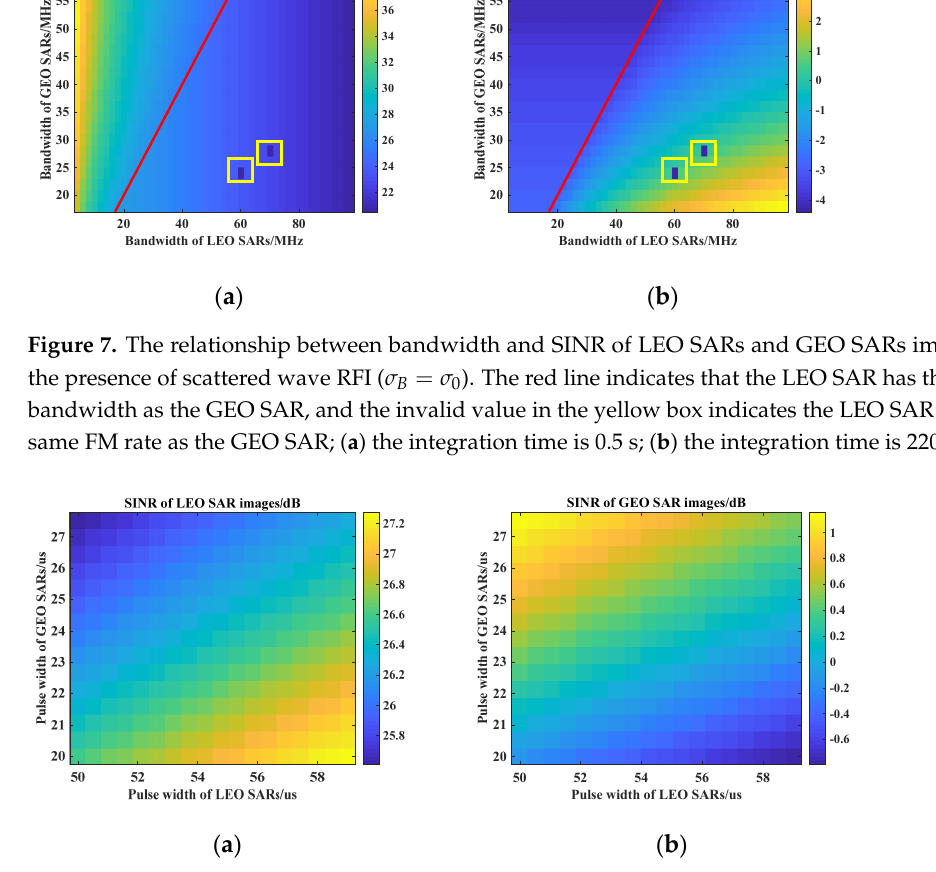
Figure 8. The relationship between pulse width and SINR of LEO SARs and GEO SARs images in the presence of scattered wave RFI ( σ B = σ 0 ); ( a ) the integration time is 0.5 s; ( b ) the integration time is 220 s.